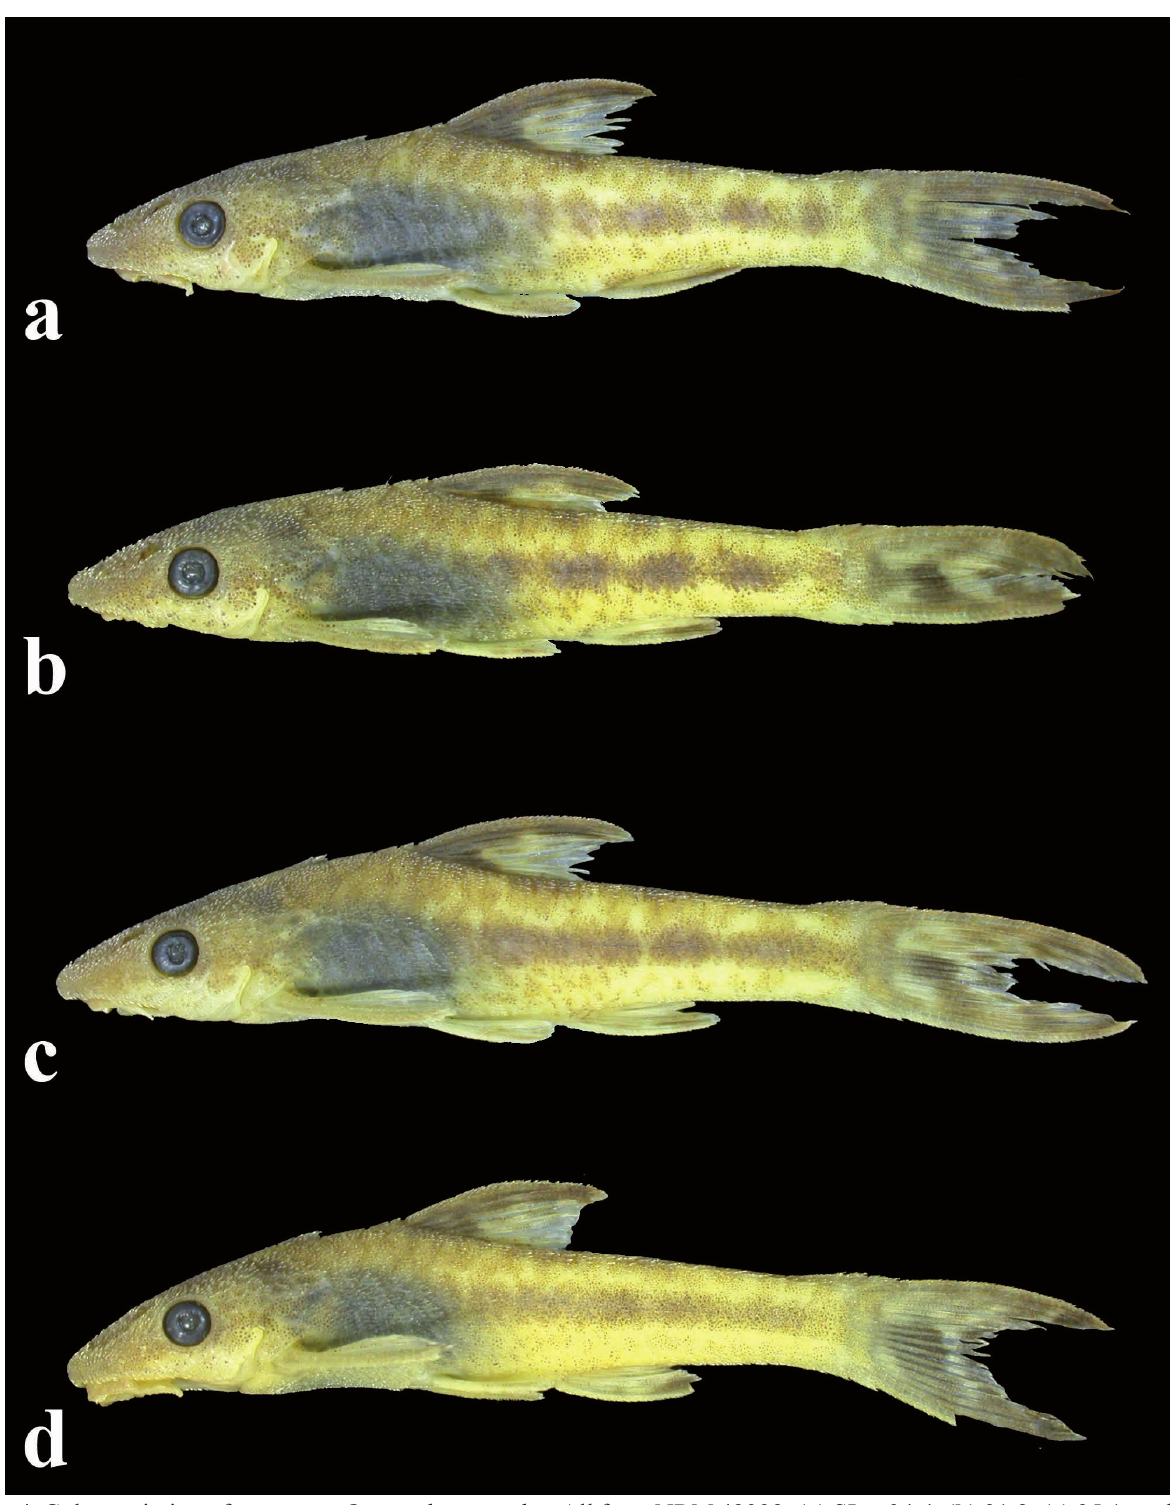
Fig. 4. Color variation of paratypes Otocinclus mimulus . All from NRM 42332, (a) SL = 34.4, (b) 31.2, (c) 35.1, and (d) 34.4